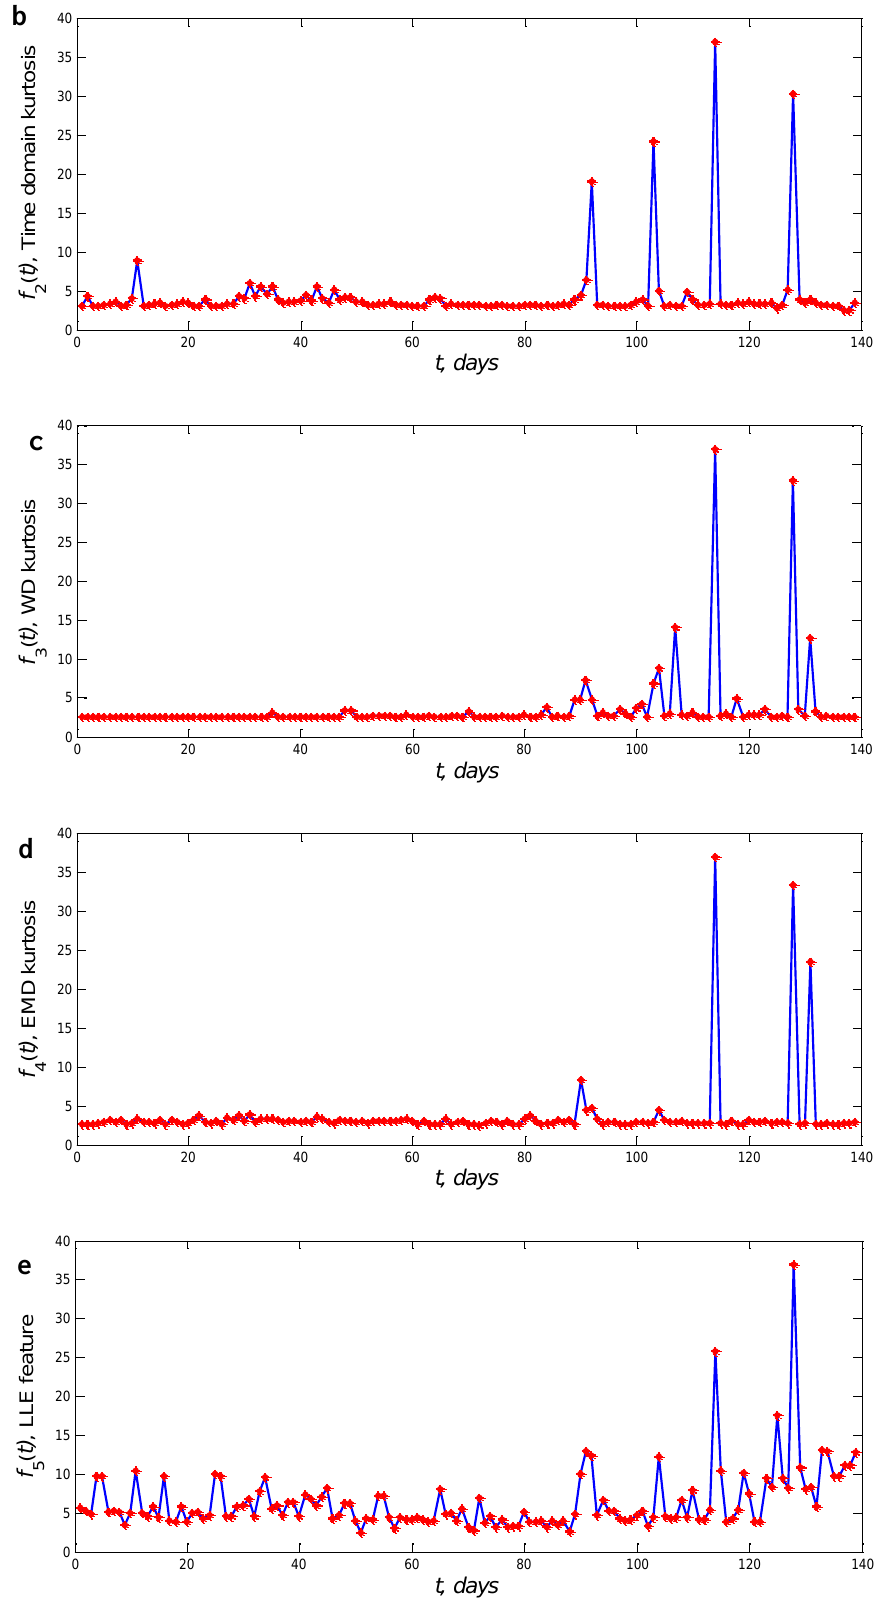
Figure 2. ( a ) circular kurtosis [32]; ( b ) time-domain kurtosis [32]; ( c ) wavelet kurtosis [32]; ( d ) EMD kurtosis [32]; ( e ) the LLE feature [33]. Note: t = dayth.